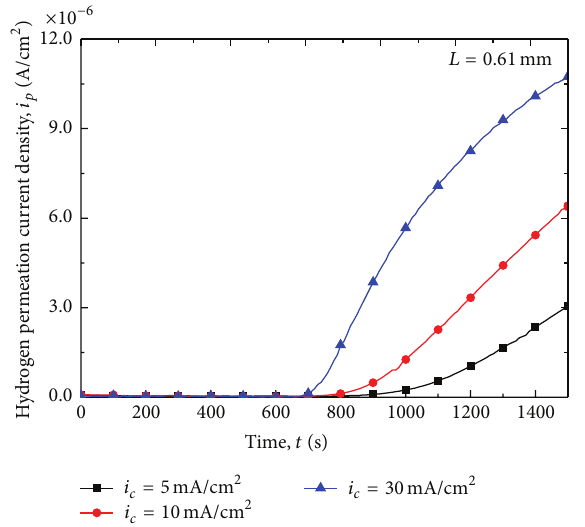
Figure 3: Hydrogen permeation curves under different hydrogen charging current density at initial charging